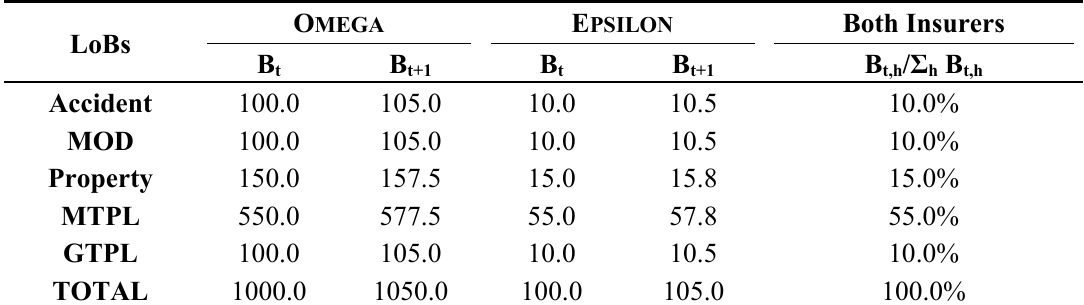
Table 2. Gross premium volumes of both insurers (amounts in mln of